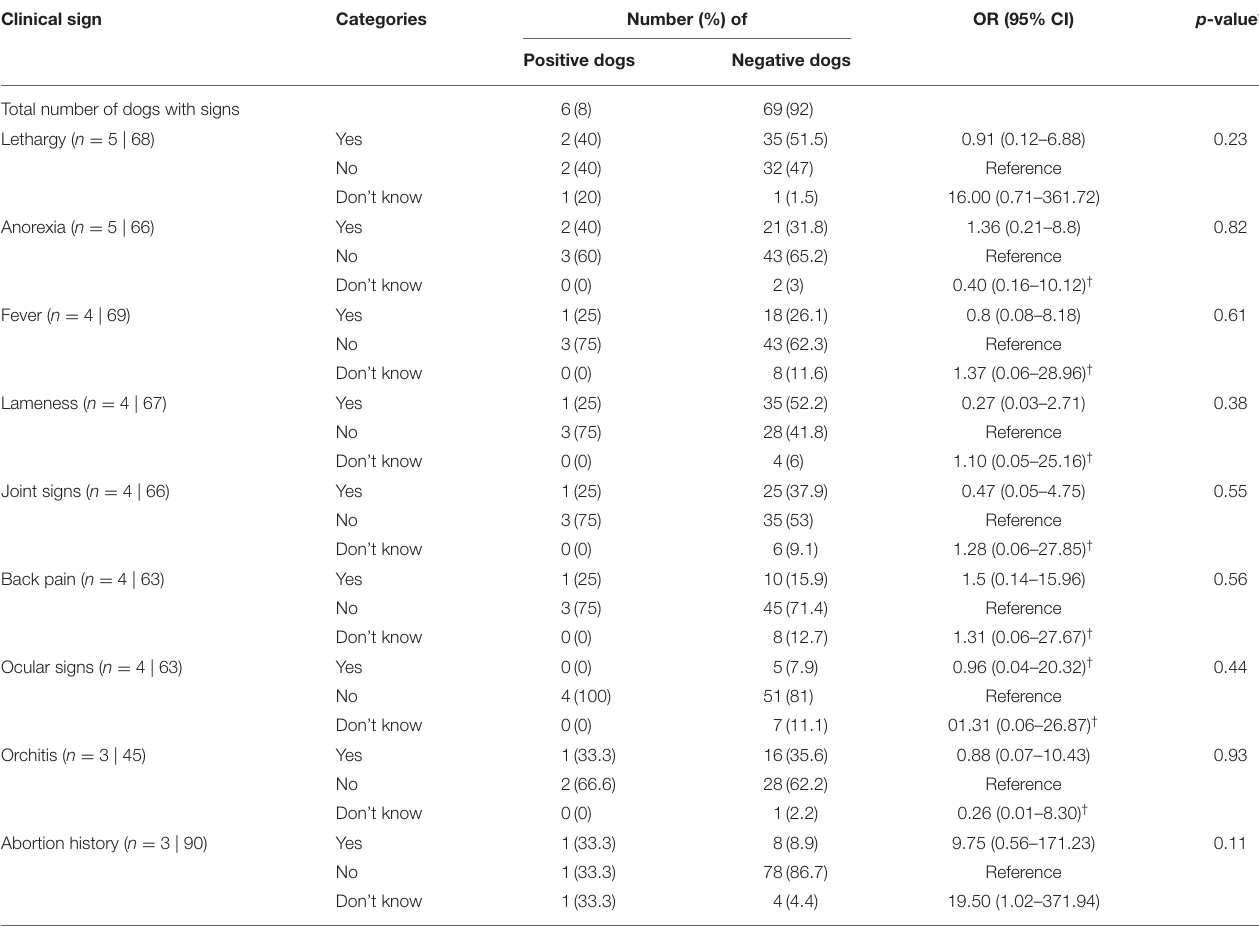
TABLE 5 | Unconditional associations between Brucella suis seropositivity and signs in subset of dogs that had clinical signs consistent with brucellosis in last week ( n = 75). Clinical